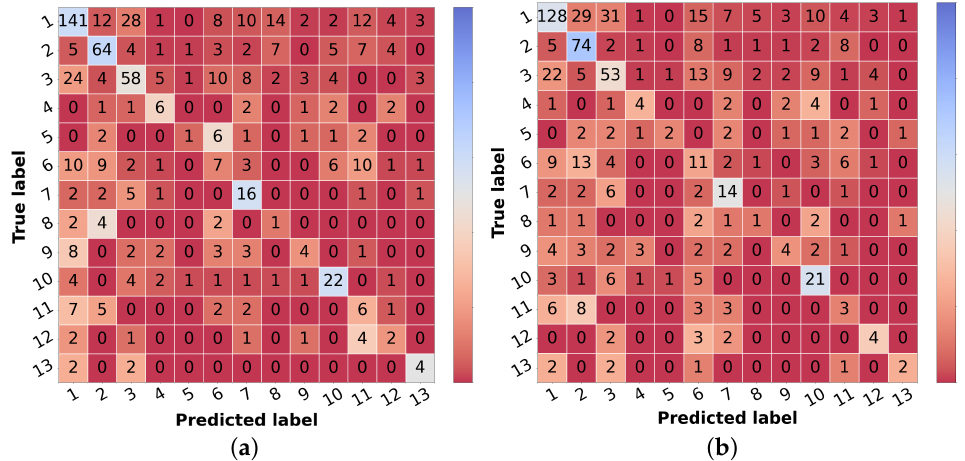
Figure 5. Confusion matrices of test set 1 for the differential diagnosis model trained with curriculum learning. ( a ) Input: image. ( b ) Input: image and metadata.